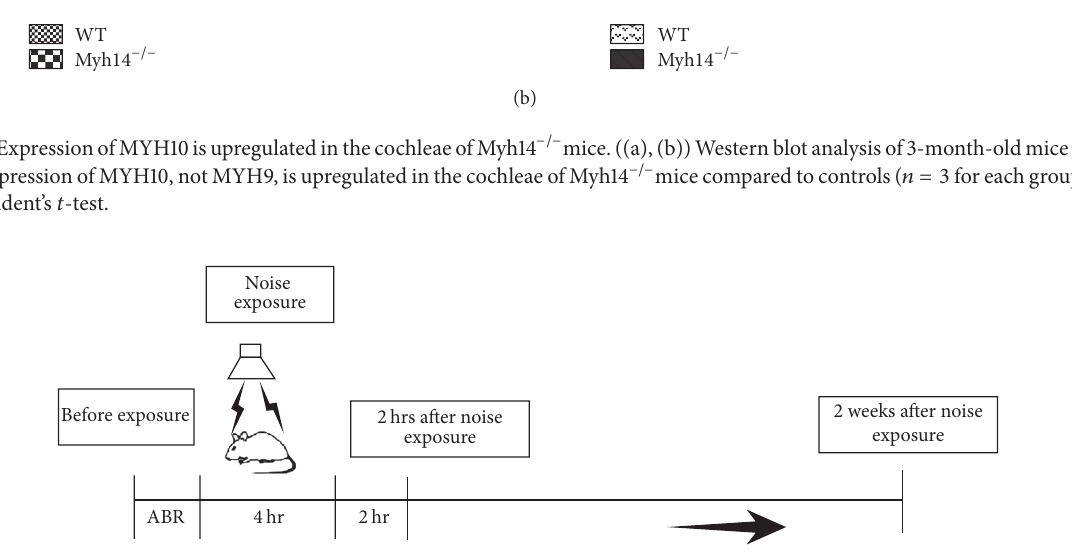
Figure 6: Experimental design for noise exposure and ABR test. Wild type and Myh14 −/− mice were exposed to noise at 105 dB for 4h. ABR thresholds were tested at the following time points: 2 h before, 2 h after, and 7 days after noise